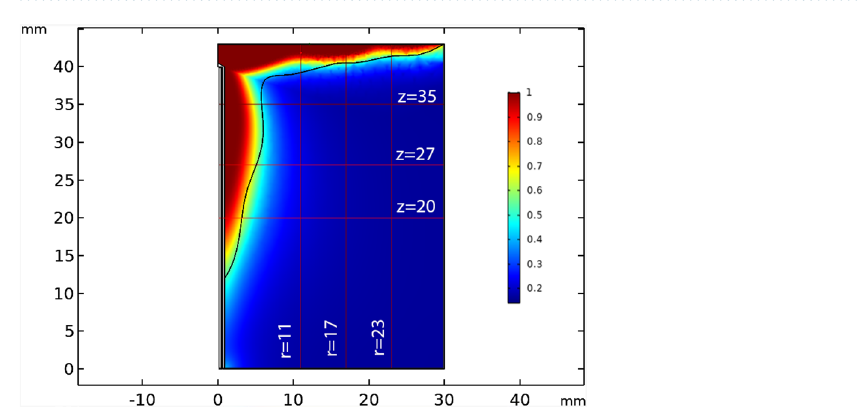
Figure 9. The fraction of damage of the tissue in the presence of gold nanoparticles when ( a ) the microwave antenna is implemented for 10 min, ( b ) pulsed laser is irradiated for 10 min, and ( c ) when both are irradiated for 10 min.